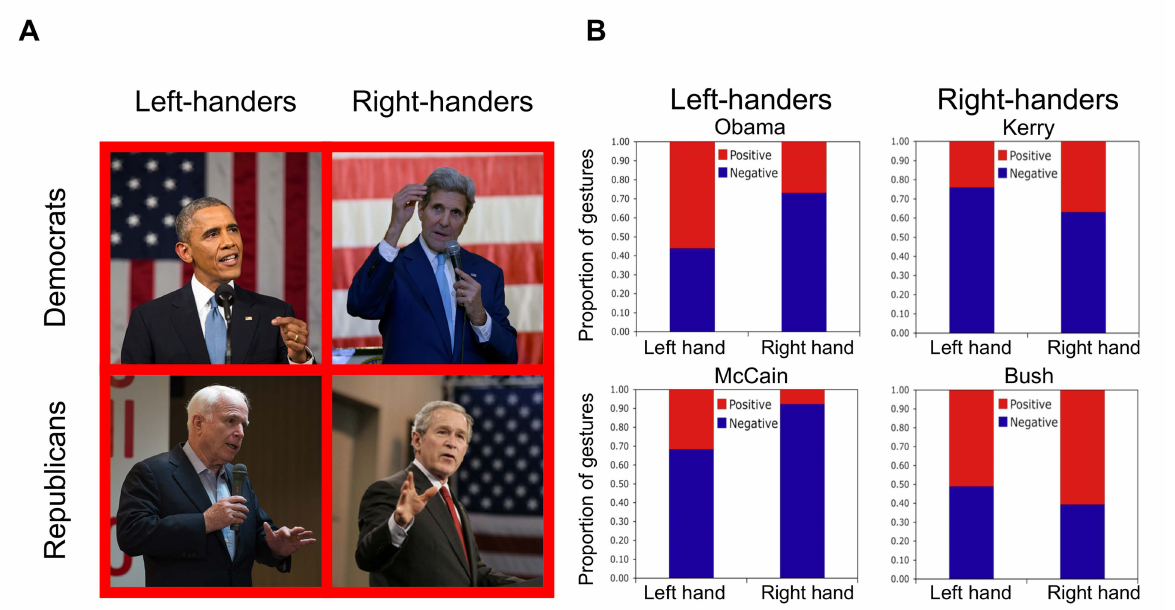
Figure 1. Examples of gestures and results of the speech-gesture analysis. A. Examples of one-handed gestures produced by the 2004 and 2008 US presidential candidates. Left panels: The left-handers, Obama (top) and McCain (bottom), gesturing with their left hands during speech with positive valence. Right panels: The right-handers, Kerry (top) and Bush (bottom), gesturing with their right hands during speech with positive valence. Due to copyright restrictions, the photos used here are for illustrative purposes only, and are not from the 2004 and 2008 US presidential debates that were analyzed in this study. B. Associations between speech and gesture in each presidential candidate. Proportions of right- and left-hand gestures during spoken clauses with positive (red) and negative (blue) emotional valence. In left-handers, left- hand gestures were more strongly associated with positive-valence speech than right-hand gestures, and right-hand gestures were more strongly associated with negative-valence clauses than left-hand gestures, but the opposite association between hand and valence was found in right-handers (Wald χ 2 = 12.65, df = 1, p = .0004). (Image sources: Official White House photography). doi:10.1371/journal.pone.0011805.g001 PLoS ONE |